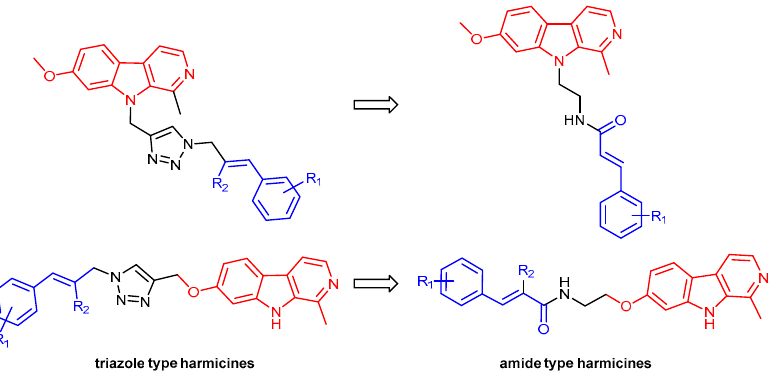
Figure 1. Triazole and amide-type harmicines (harmine is marked in red, while the cinnamic acid derivative (CAD) scaffold is marked in blue).